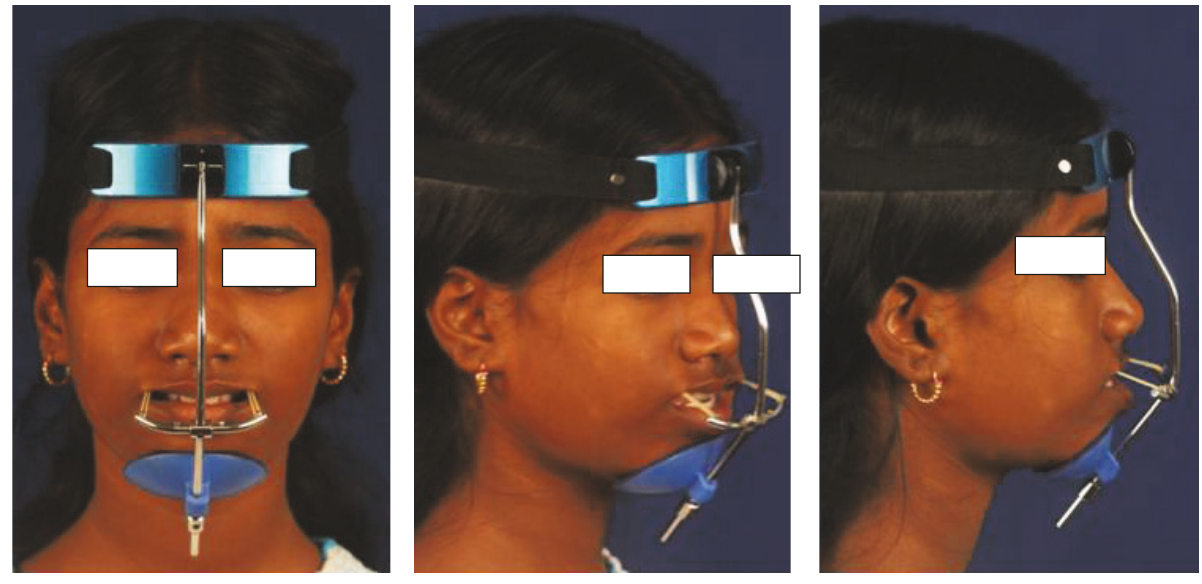
Figure 3: Facemask